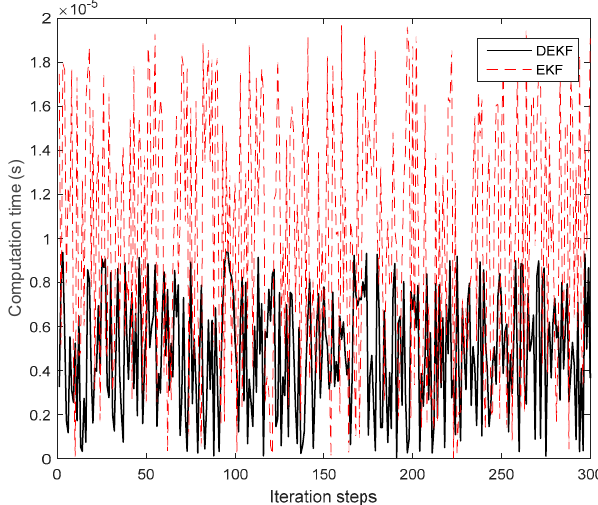
Figure 8. The computation time of each step.